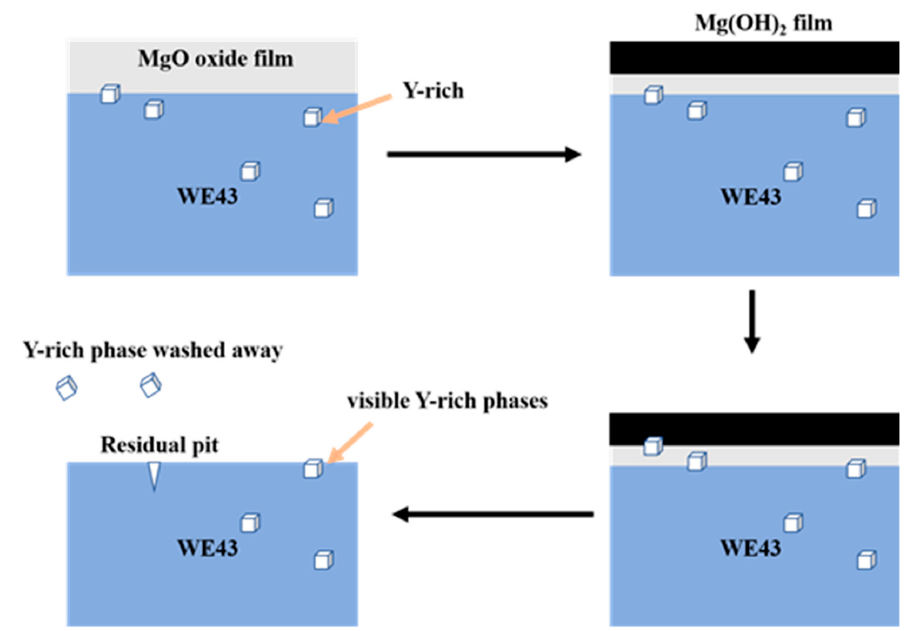
Figure 11. Schematic illustration for the effect of Y-rich phase on corrosion behavior.